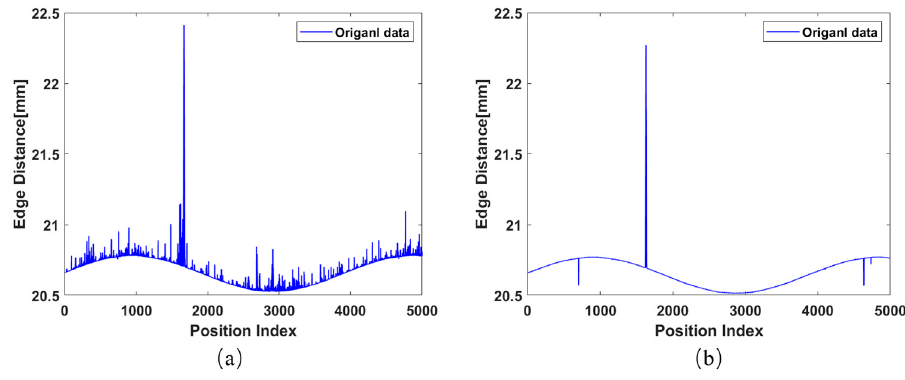
Figure 8. ( a ) The edge distance of wafer A with a poor surface; ( b ) the edge distance of wafer B with a good surface.